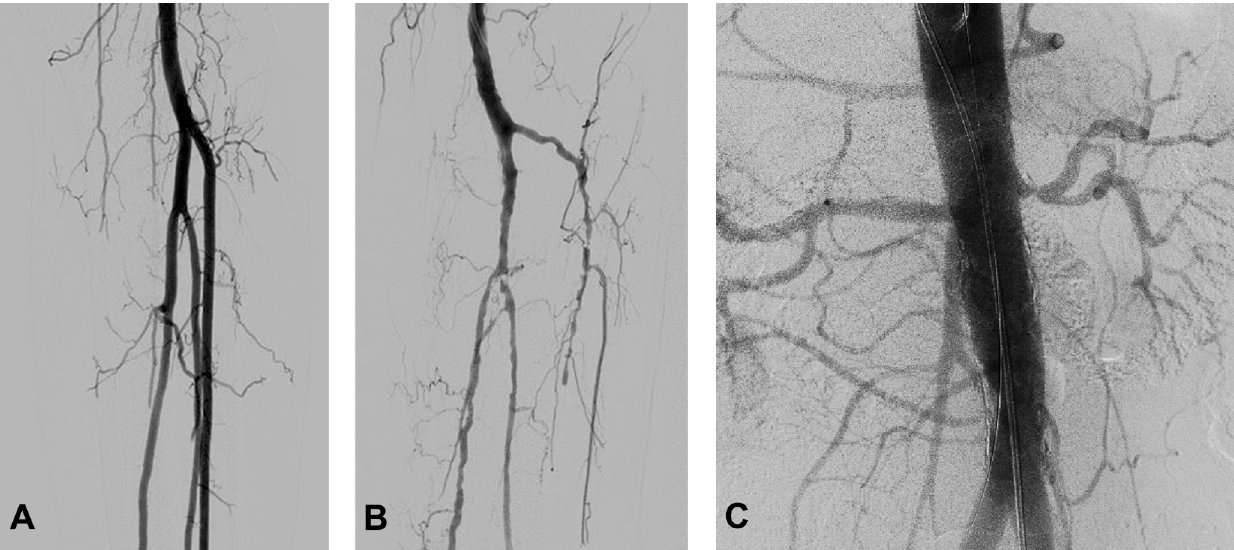
Fig 4. DSA imaging of A) the trifurcation and crural arteries of a specimen with patent arteries, B) the trifurcation and crural arteries of a specimen with systemic atherosclerosis and C) the abdominal aorta and its visceral and renal branches.